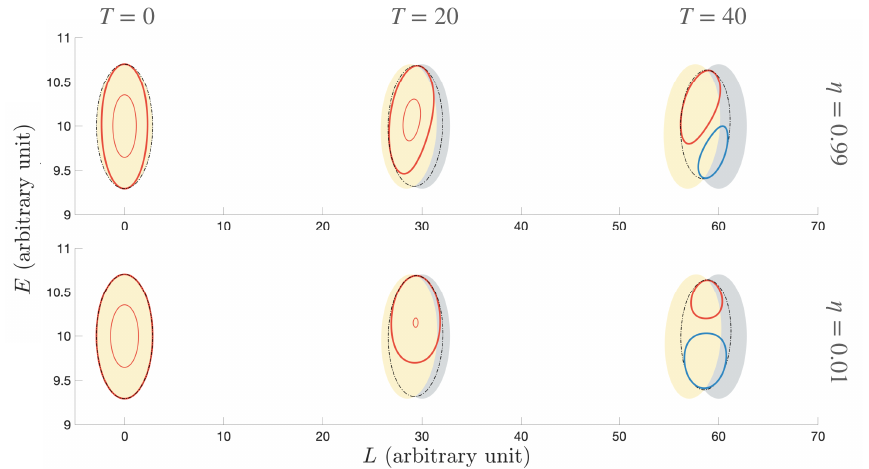
Figure 5 . Same as figure 4, but demonstrating the FTP in eq. (2.41) on the physical layer, also assuming Gaussian distributed weighting functions. The differences between each FTP are labeled on the figure, showing the time evolution of the FTP and the effect of the alignment